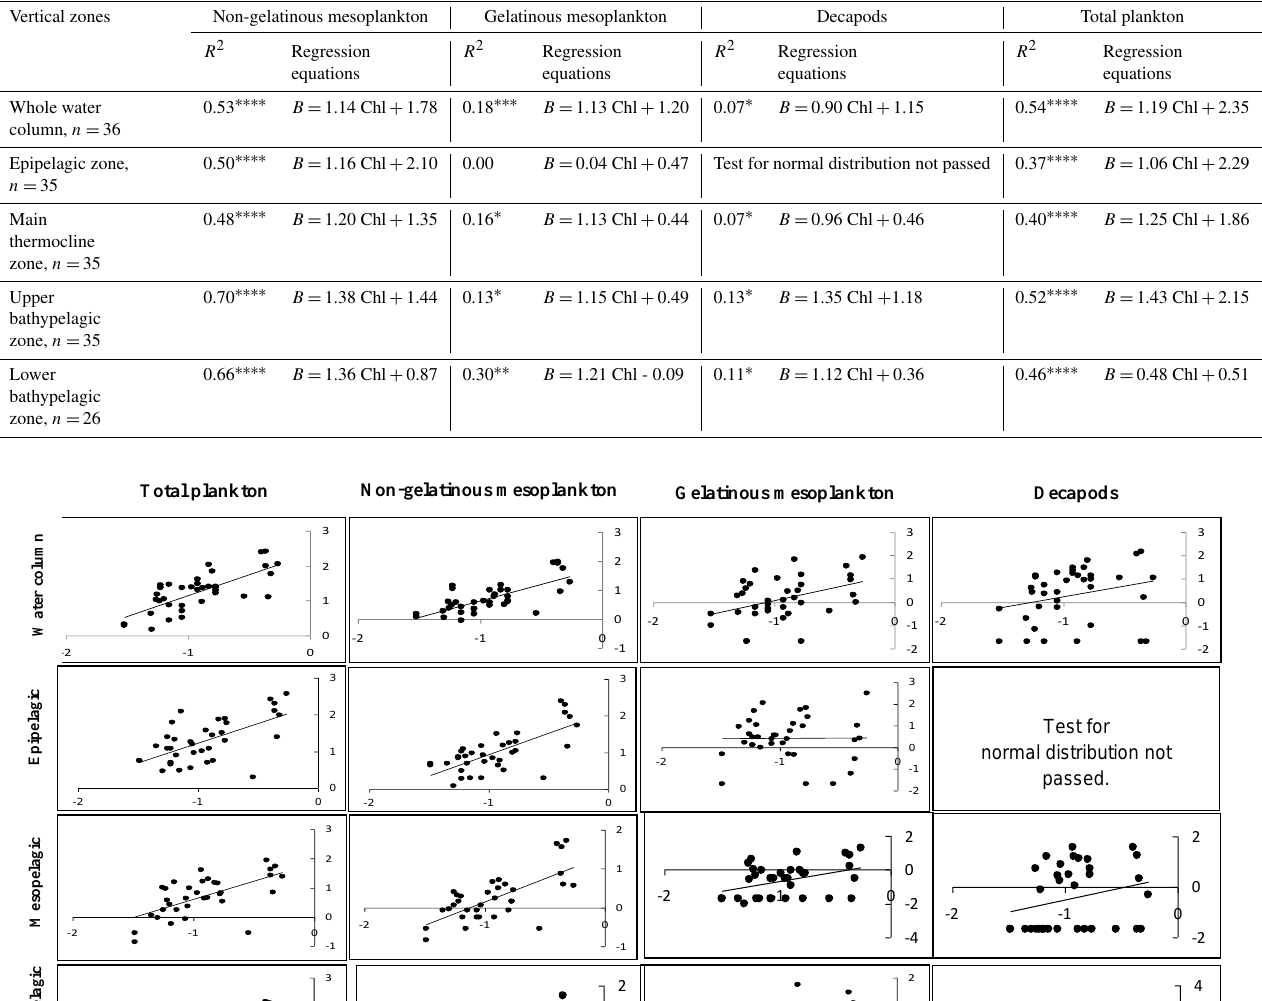
Table 3. Correlations between log-transformed values of surface chlorophyll a concentration (Chl, mgm − 2 ) and wet biomass ( B , gm − 2 for the whole water column and mgm − 3 for vertical zones): coefficients of determination ( R − 2 ), equations, and levels of significance ( ∗∗∗∗ indicate p< 0 . 001, ∗∗∗ for p< 0 . 01, ∗∗ for p< 0 . 01, ∗ for p< 0 . 05).